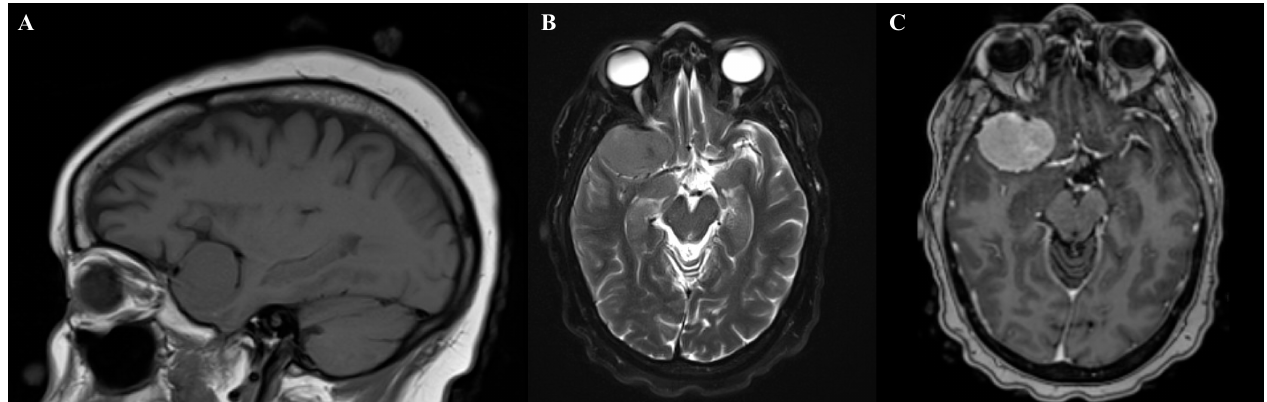
Figure 2. Magnetic resonance imaging of right sphenoid wing meningioma. ( A ) Sagittal T1. ( B ) Axial T2. ( C ) T1+gadolinium contrast.